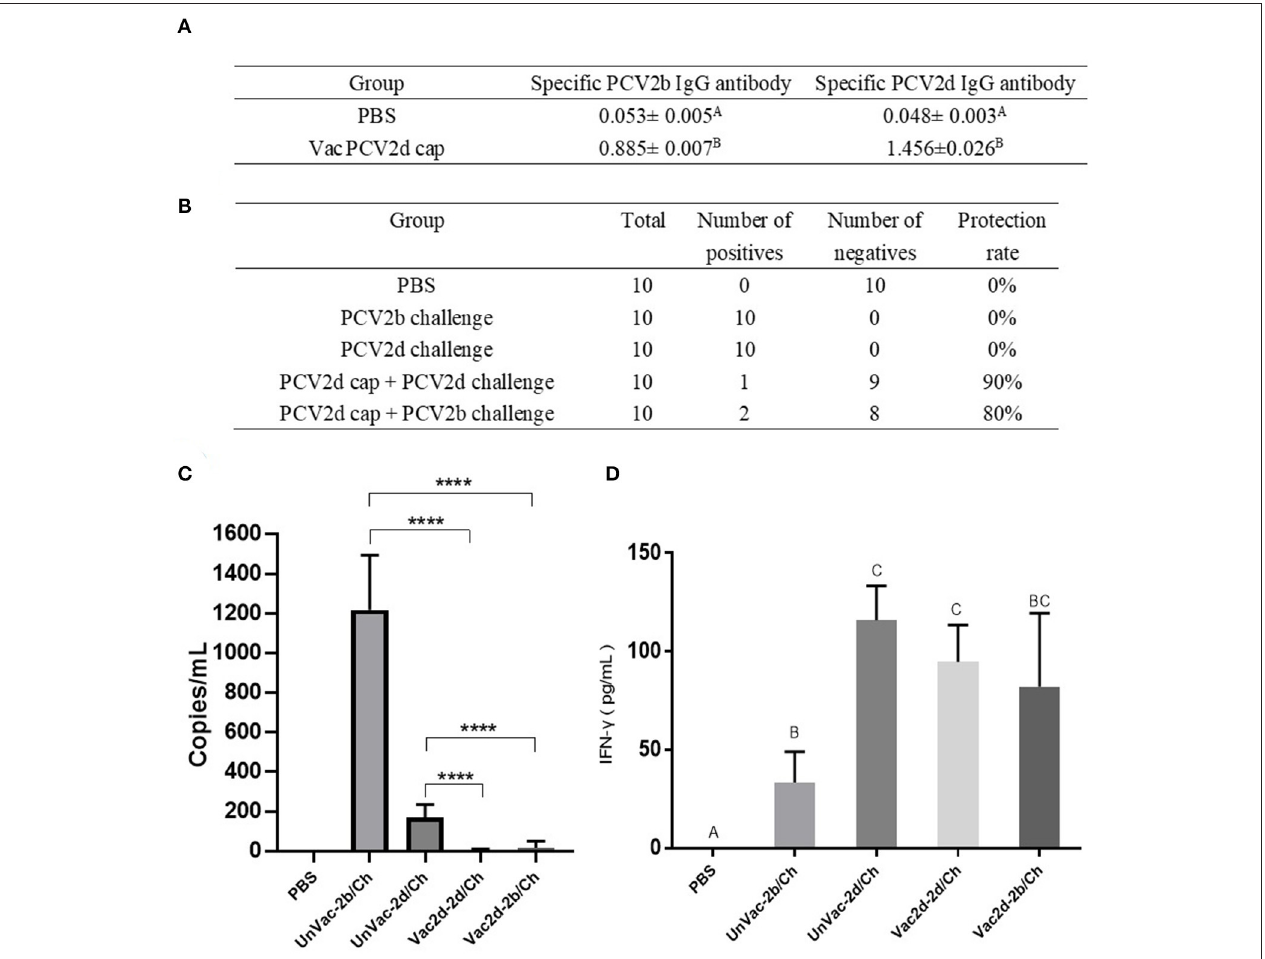
FIGURE 7 | Homologous and heterologous immune response of PCV2d Cap protein against the PCV2b and PCV2dagainst the PCV2b and PCV2d. (A) Specific antibody levels for PCV2b and PCV2d Cap proteins at 0 dpc. (B) Detection of PCV2 DNA in serum by PCR at 14 dpc. (C) Detection of the PCV2 DNA load in serum by RT-PCR at 14 dpc. (D) Levels of IFN- γ in blood at 14 dpc. The data are presented as group mean optical density (M OD ± standard error). Significant differences are indicated by different superscripts (A–C) ( p < 0.05). Data were analyzed using one-way analysis of variance with Dunnett’s multiple comparisons test using GraphPad Prism 7 software (GraphPad Software, USA), **** p <